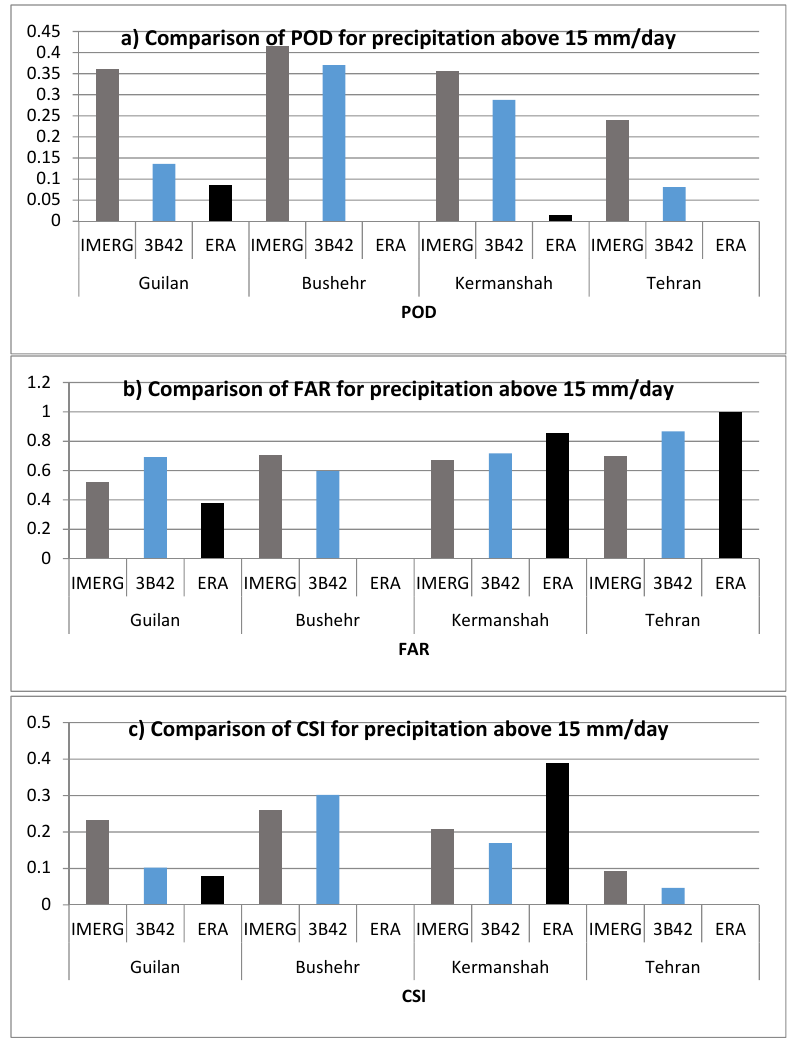
Figure 18. ( a – c ) POD, FAR and CSI in four study regions for precipitation above 15 mm/day. Table 18. Spatially averaged POD, FAR and CSI metrics for precipitation above 15 mm/day.